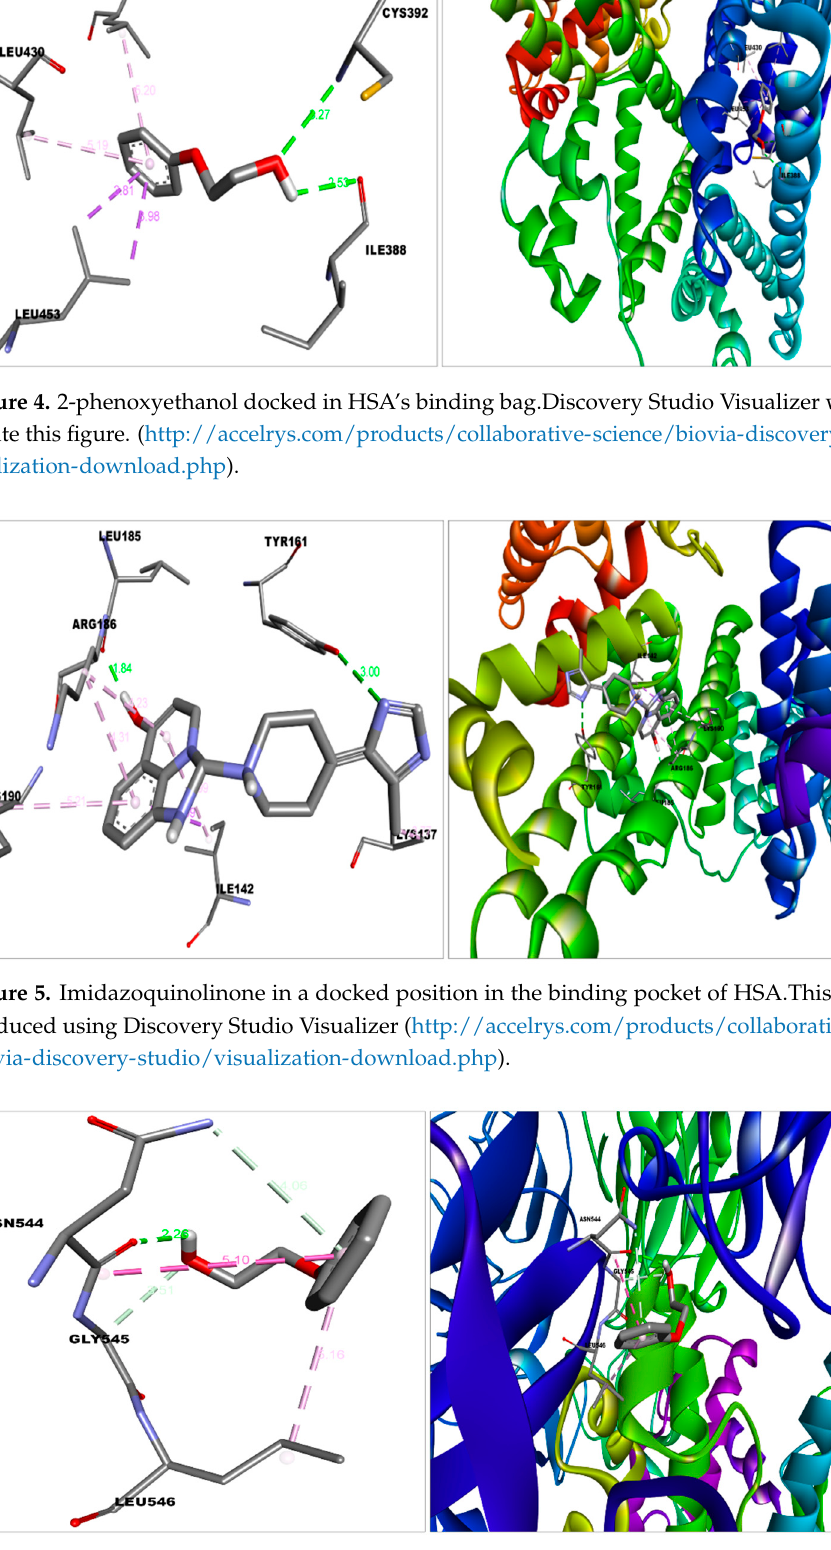
Figure 6. 2-phenoxyethanol docked in the binding pocket of S protein.A Discovery studio visualizer was used to build this diagram. (http://accelrys.com/products/collaborative-science/biovia-discov- ery-studio/visualization-download.php).